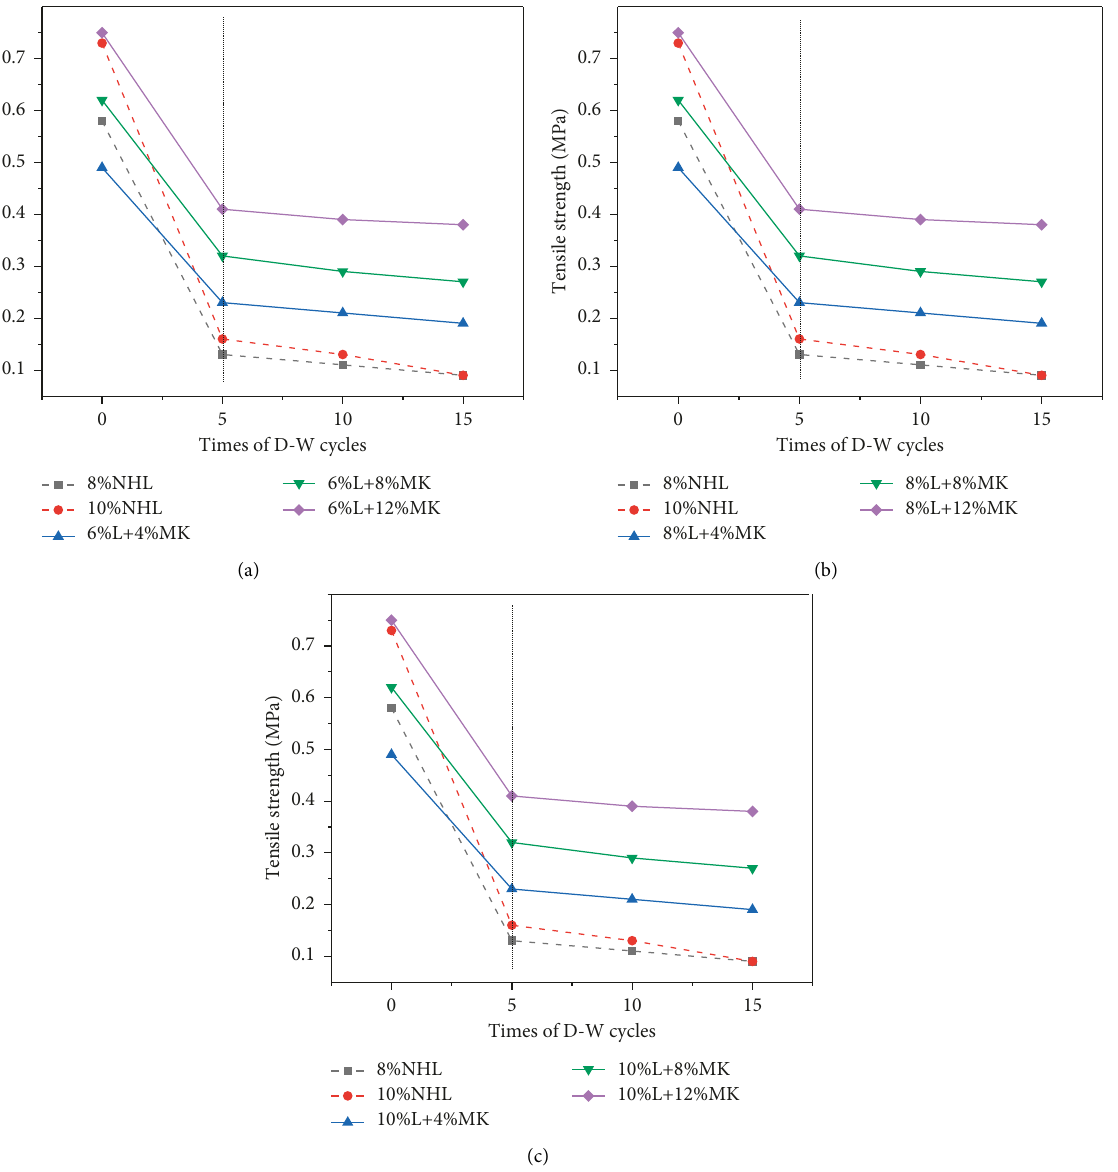
Figure 8: Relationship between the tensile strength of L-MK- and NHL-modified soils and the number of dry-wet cycles. (a) 6% L-MK and NHL. (b) 8% L-MK and NHL. (c) 10% L-MK and